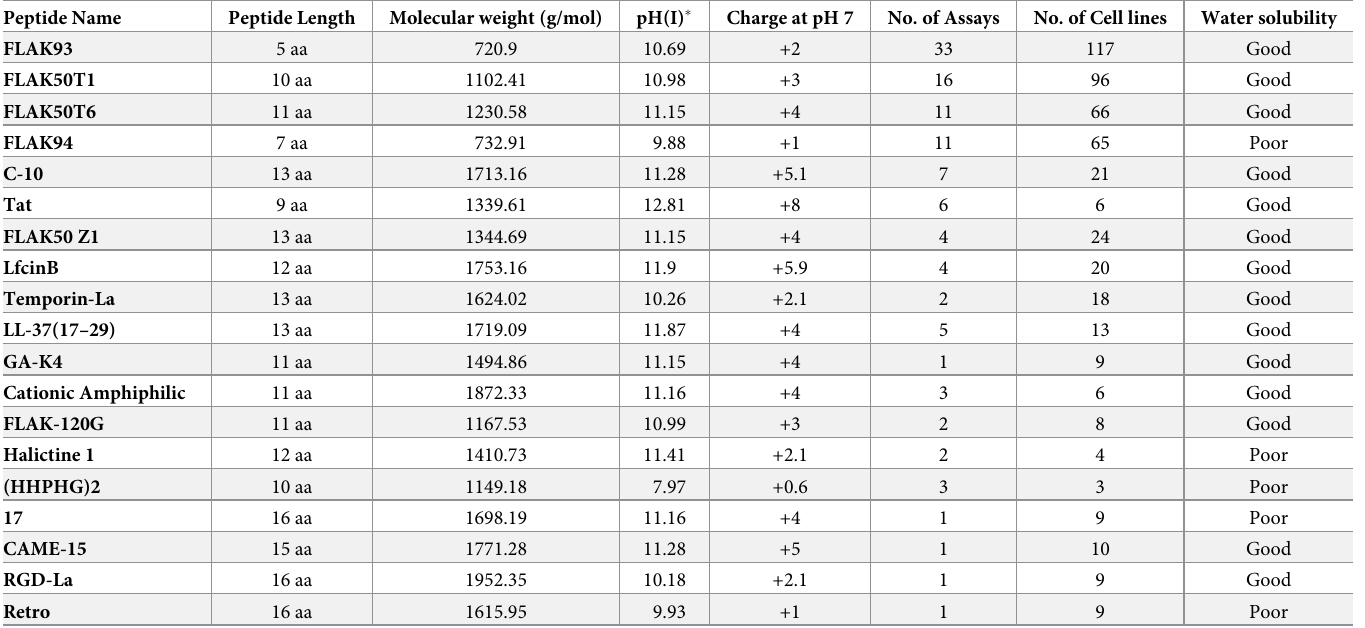
Table 1. Physicochemical properties and number of assays and cell lines used for validation of anti-cancer capability of studied peptides. Peptide